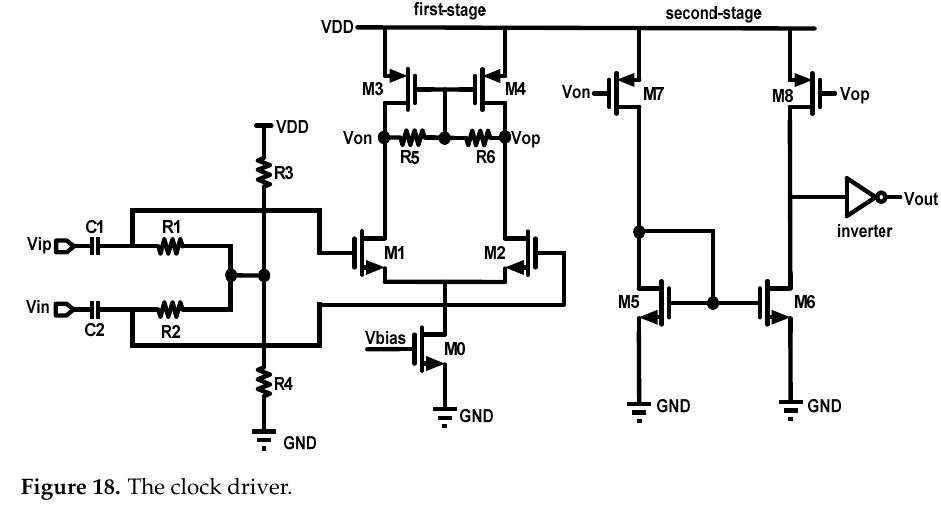
Figure 18. The clock driver.